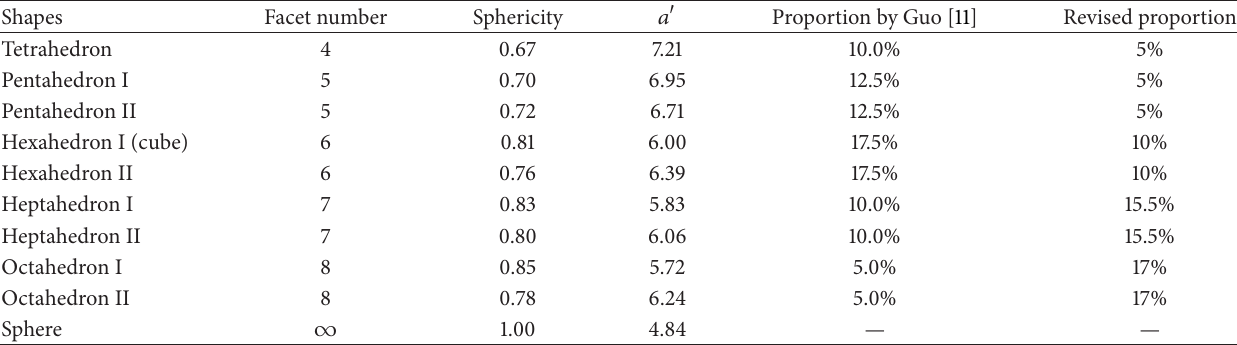
Table 2: Shape indices of the regular polyhedra, appropriate proportions according to Guo [11], and revised proportions for better overall simulation